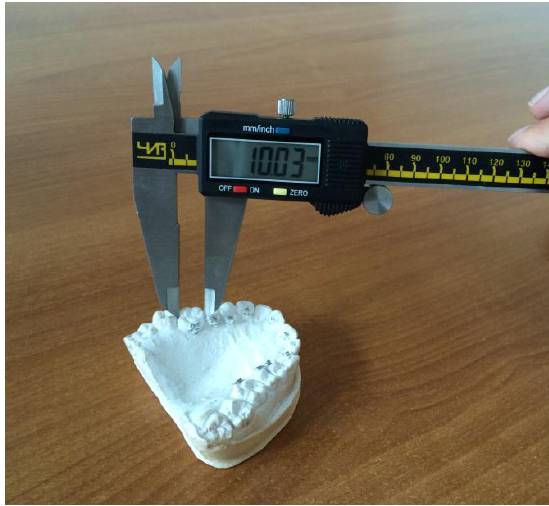
Figure 1. Measurements on plaster cast dental arch